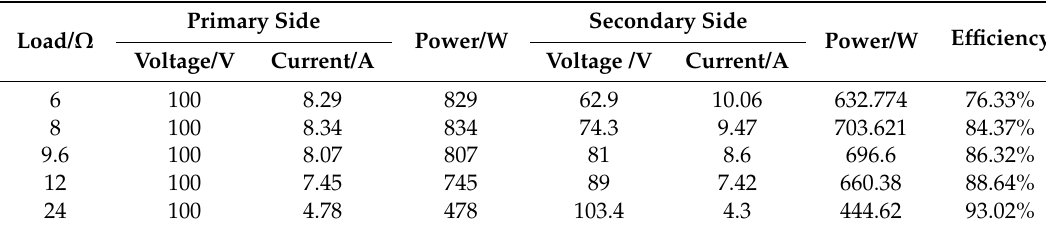
Table 2. Load influence on system efficiency without load adaptive control.